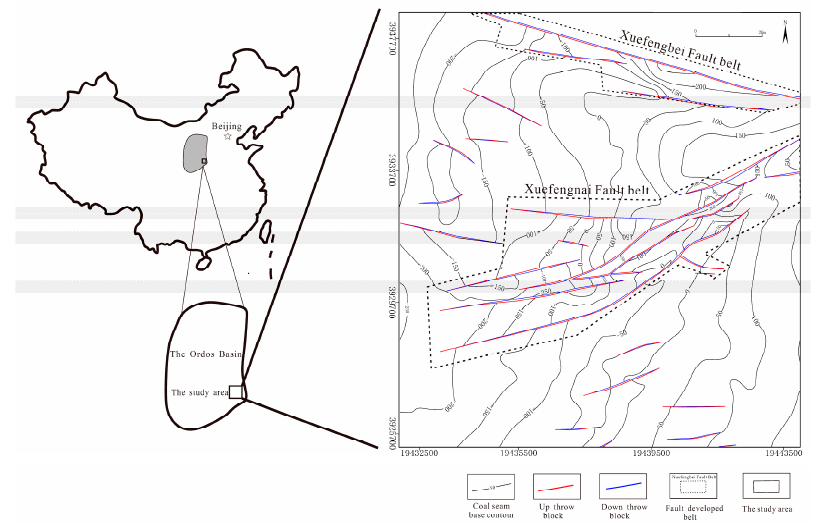
Figure 1. Location and geological structure of the Hancheng (HC) block (the structural outline is from the No. 11 coal seam base).